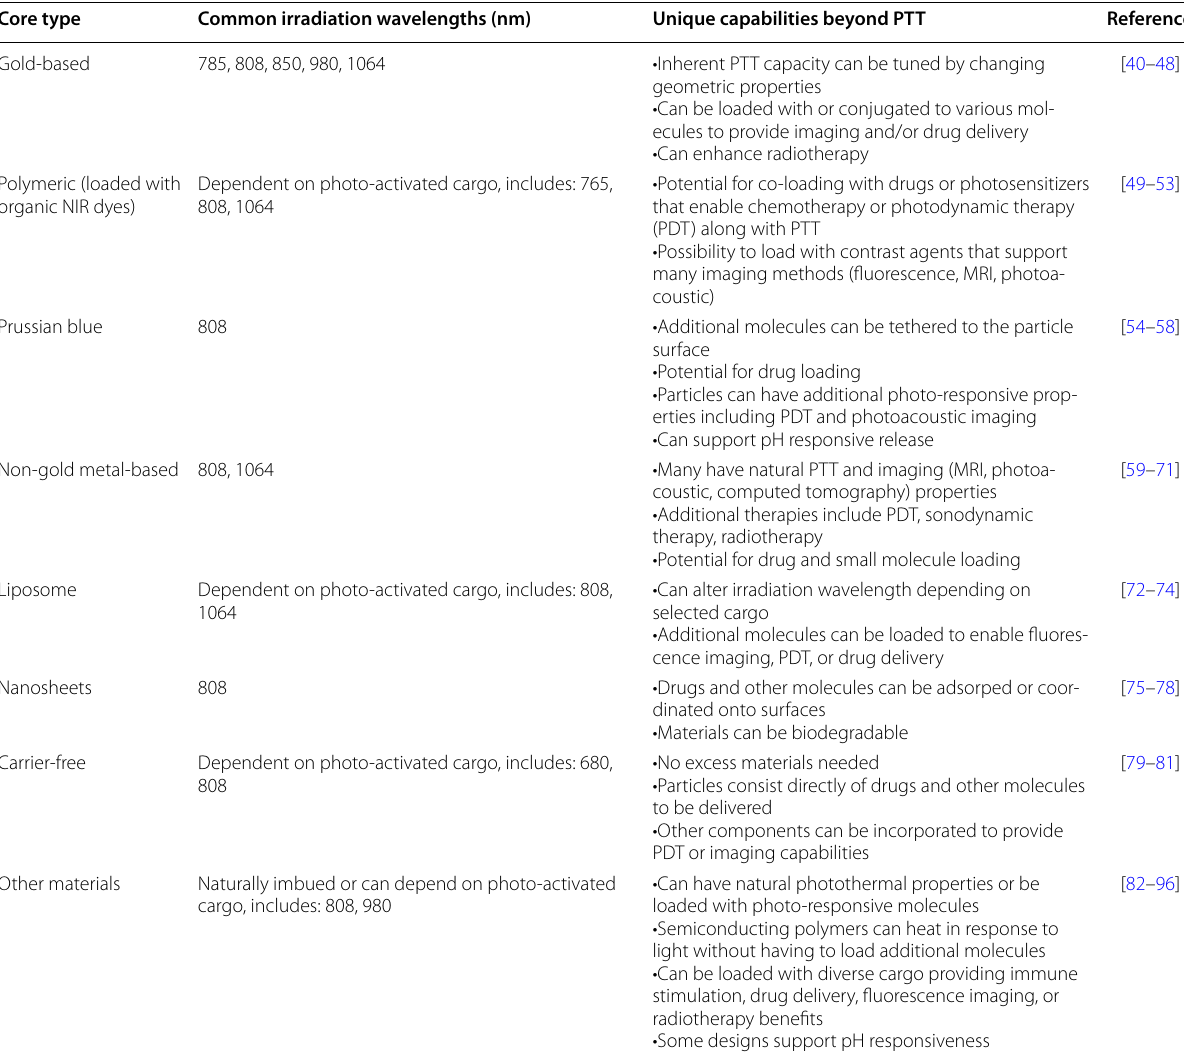
Table 1 Different cores used in biomimetic PTT systems and their unique